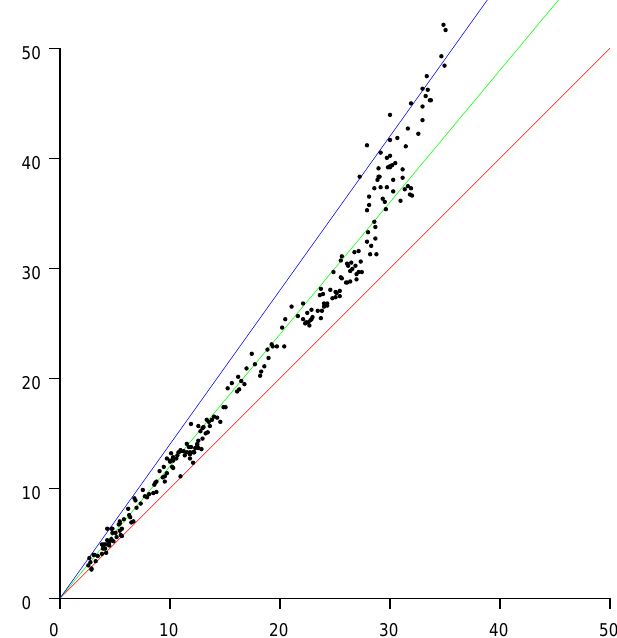
Figure 9. Scattergram of measured distances versus actual distance in a large open plan office building. Vertical axis: measured distance (meters). Horizontal axis: actual distance (meters). Red line (slope 1) is the ideal relationship. Green line (slope 1.2) is the best linear fit. Blue line (slope 1.4) is an upper extreme. The high permittivity of building materials biases the distances measured by FTM